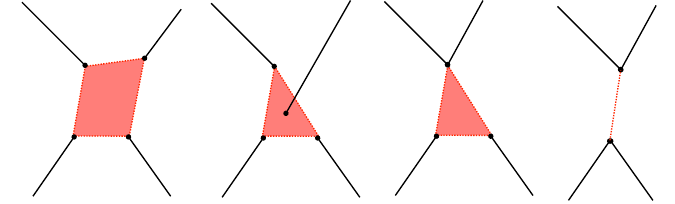
Figure 27. An on-shell scattering process must lie inside the convex hull de(cid:12)ned by the vertices attached to external lines. This is due to momentum conservation: an on-shell internal particle that wandered outside the convex hull would never be able to move back inside, since there would be no external momentum available to kick it back in. There are 3 possible convex hulls for 2 amplitudes: a quadrilateral, a triangle, or a line.